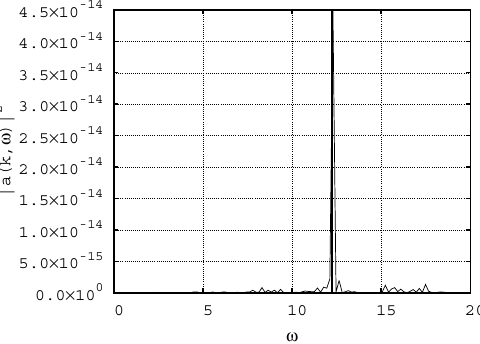
Figure 9. Steepness as a function of absolute value of wave number. Only the condensate was suppressed.